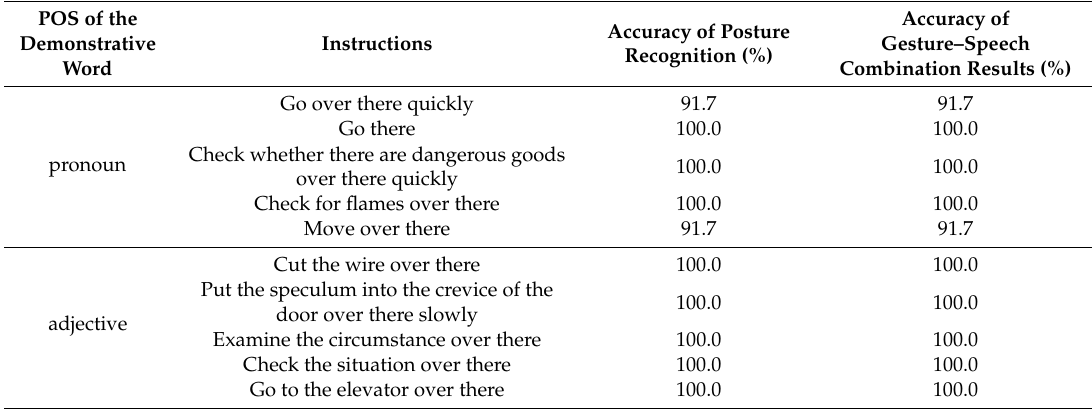
Table 14. Experimental results using hand postures and the text of voice